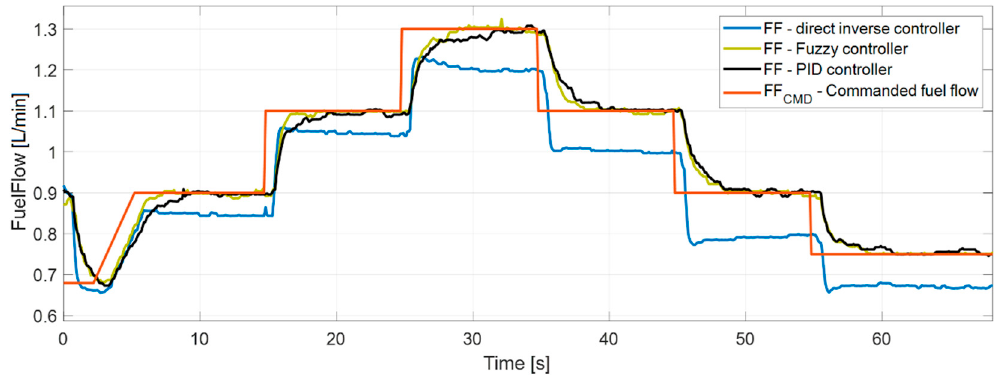
Figure 16. Performance of the controllers with running engine—iSTC ‐ 21v.